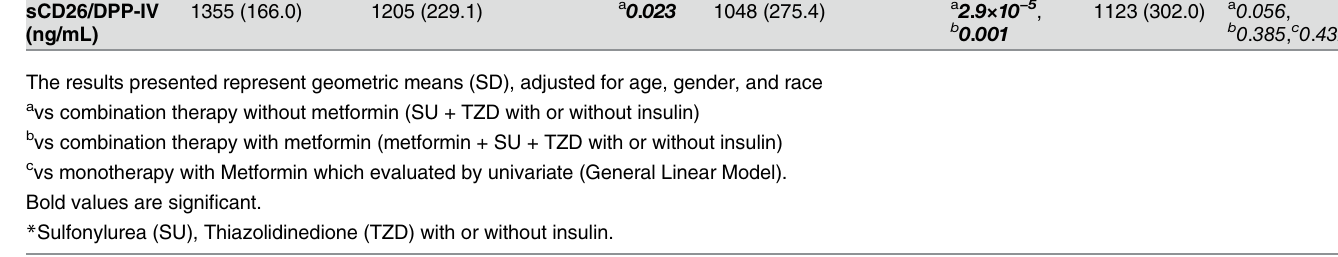
Table 6. Comparison of fasting serum levels of sCD26/DPP-IV between combination therapy without metformin, combination therapy with metfor- min, monotherapy with metformin and non- treated among subjects with type 2 diabetes. * SU +TZD w/wo insulin(n = 28)